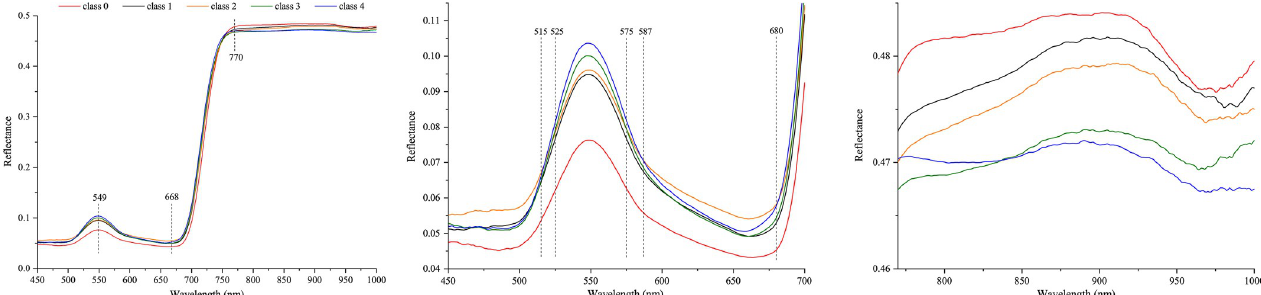
Fig 4. Hyperspectral curves of five classes of soybean FLS leaves. (a) Hyperspectral ranges of 450–1,000 nm, (b) zoomed in hyperspectral ranges of 450–700 nm, and (c) zoomed in hyperspectral ranges of 770–1,000 nm.